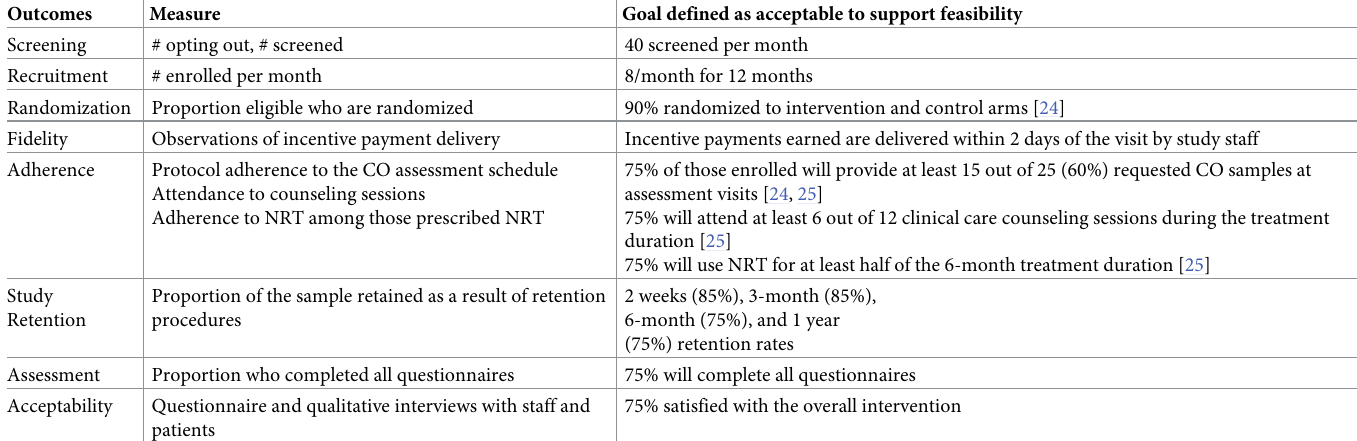
Table 2. Feasibility and acceptability